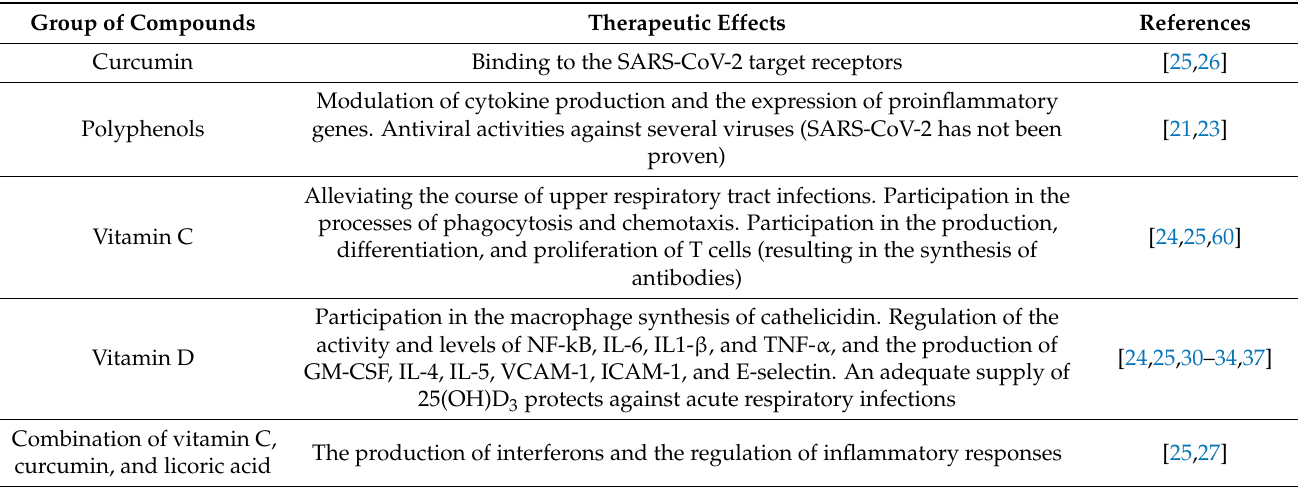
Table 1. Group of compounds showing potential beneficial effects in the prevention and treatment of SARS-CoV-2 infection. Group of Compounds Therapeutic